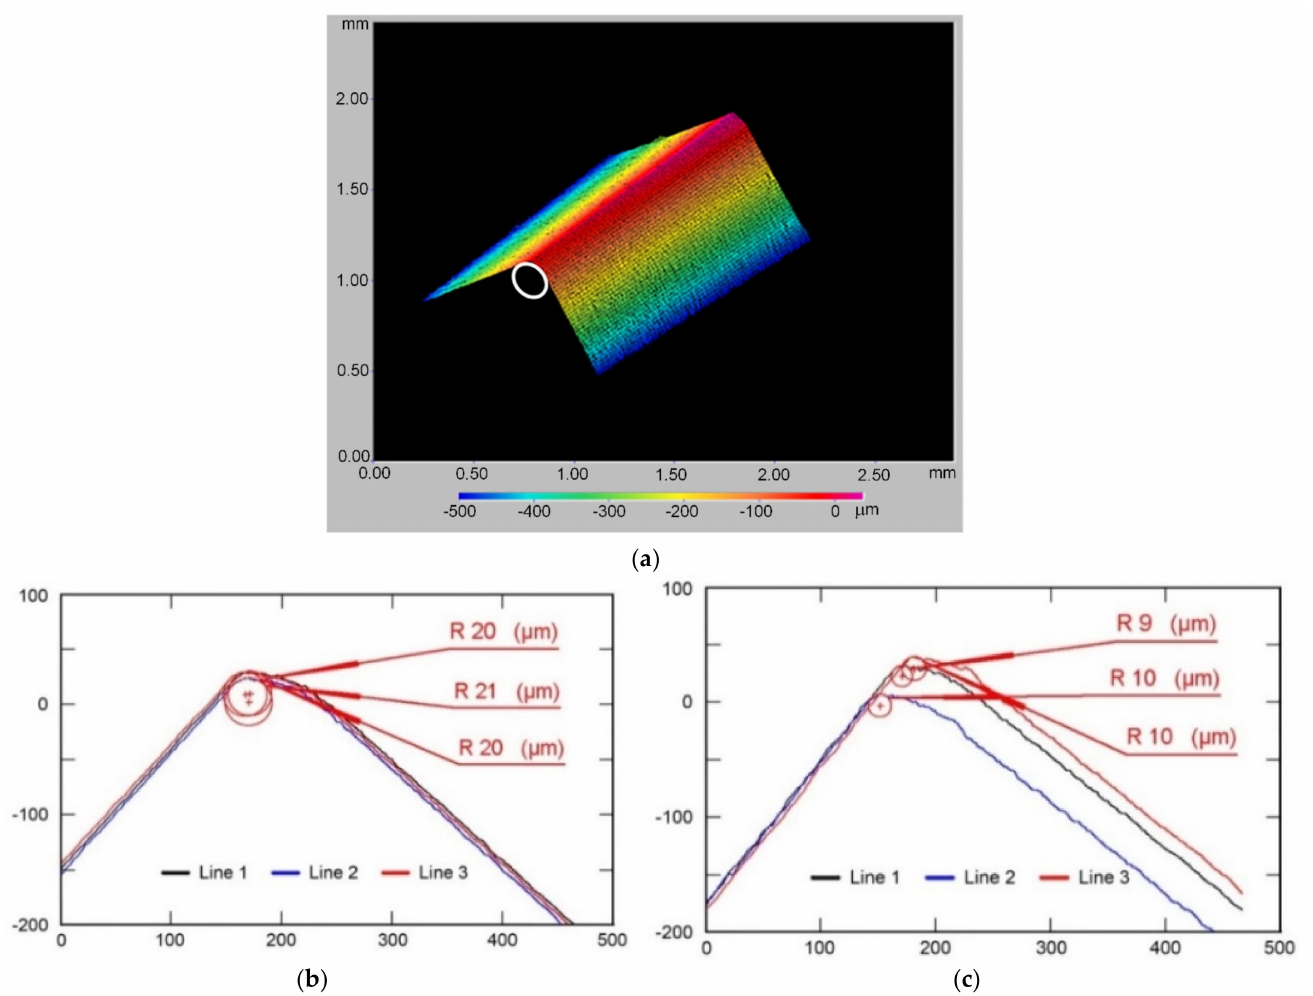
Figure 11. ( a ) 3D image of the cutting wedge surface with a circle inscribed in the wedge top; ( b ) profiles of cutting wedge in three sections distanced from each other at 0.3 mm with measured radii R of the cutting edge for the initial cutting plate; ( c ) profiles of the cutting wedges with measured radii R of the cutting edge for a cutting plate subjected to removal of a defective surface layer by fast argon